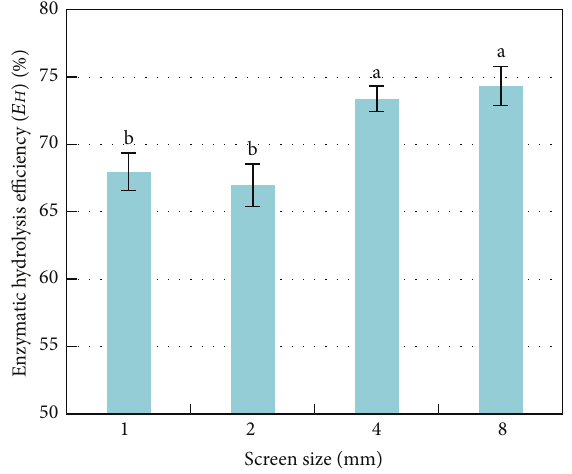
Figure 9: Effects of screen size on biomass weight loss in pretreat- ment.